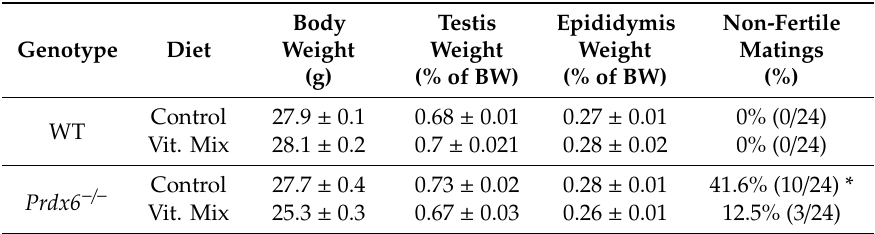
Table 1. Body, testis and epididymis weights and fertile